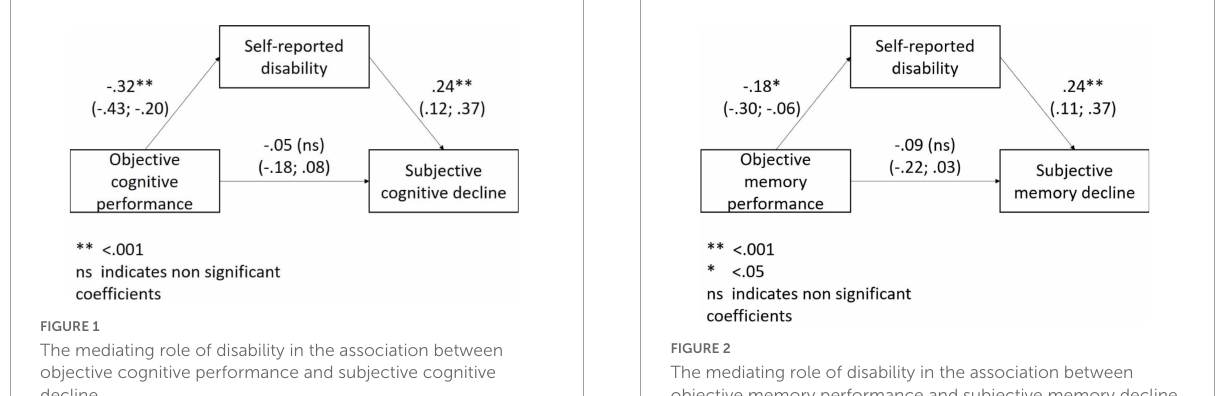
FIGURE1 The mediating role of disability in the association between objective cognitive performance and subjective cognitive decline.